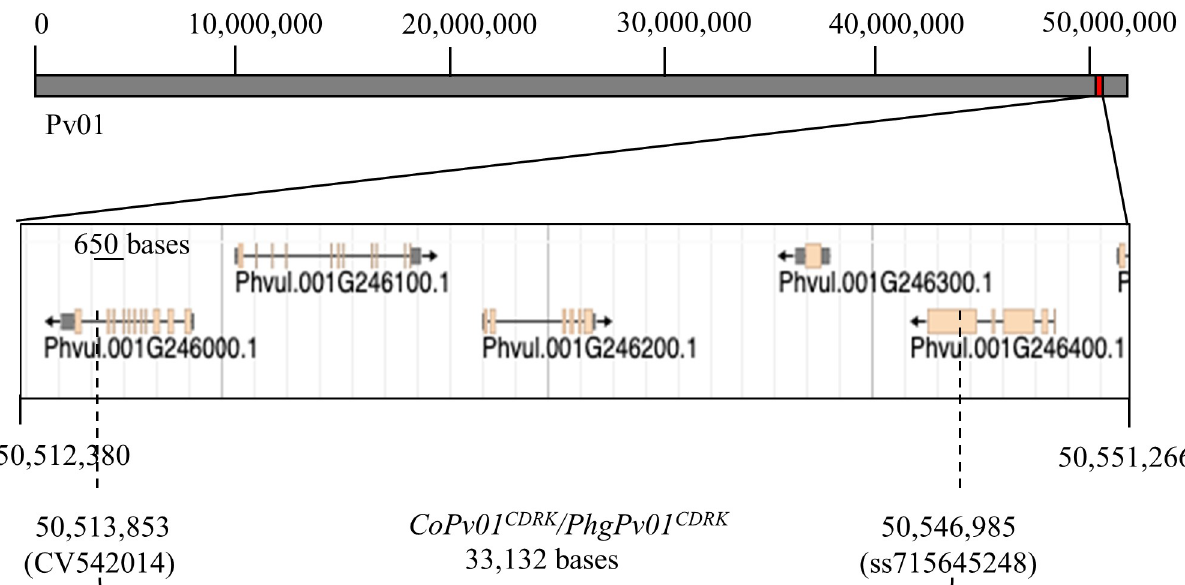
Fig 2. Fine mapped region for the CDRK resistance loci CoPv01 CDRK /PhgPv01 CDRK . Upper bar represents the entire chromosome Pv01, in which the CoPv01 CDRK /PhgPv01 CDRK region is highlighted as red square at the end of the chromosome. The five predicted genes within this region are shown, where the location of the CoPv01 CDRK /PhgPv01 CDRK flanking markers CV542014 and ss715645248 are indicated by dashed lines, within the predicted genes Phvul.001G246000 and Phvul.001G246400, respectively. The genomic region between these markers is indicated by the lower bar and cover around 33 Kbp of the genome. https://doi.org/10.1371/journal.pone.0235215.g002 was found 26 Kb downstream of the marker ss715645248 (Table 4). These five genes are inter- esting candidates for CoPv01 CDRK /PhgPv01 CDRK and may confer resistance to ANT and ALS pathogens. The Fig 3 shows the ANT resistance cluster present at the end of chromosome Pv01. Table 4. Gene models found in delimitated region CDRK resistance loci against anthracnose and angular leaf spot were fine-mapped, gene position in reference genome v1.0 and annotation. Gene Model in P . Homolog in A